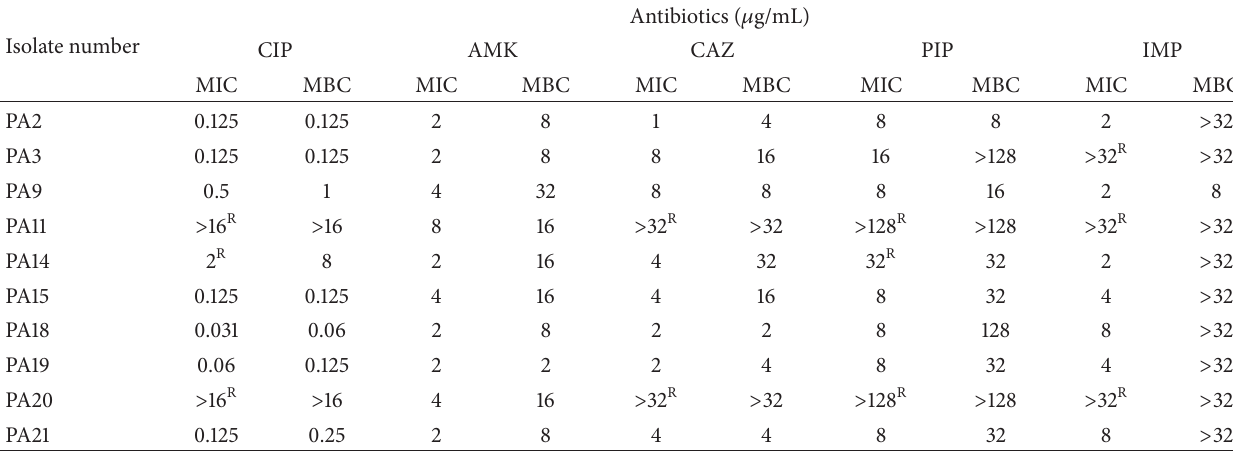
Antibiotics ( 𝜇 g/mL)